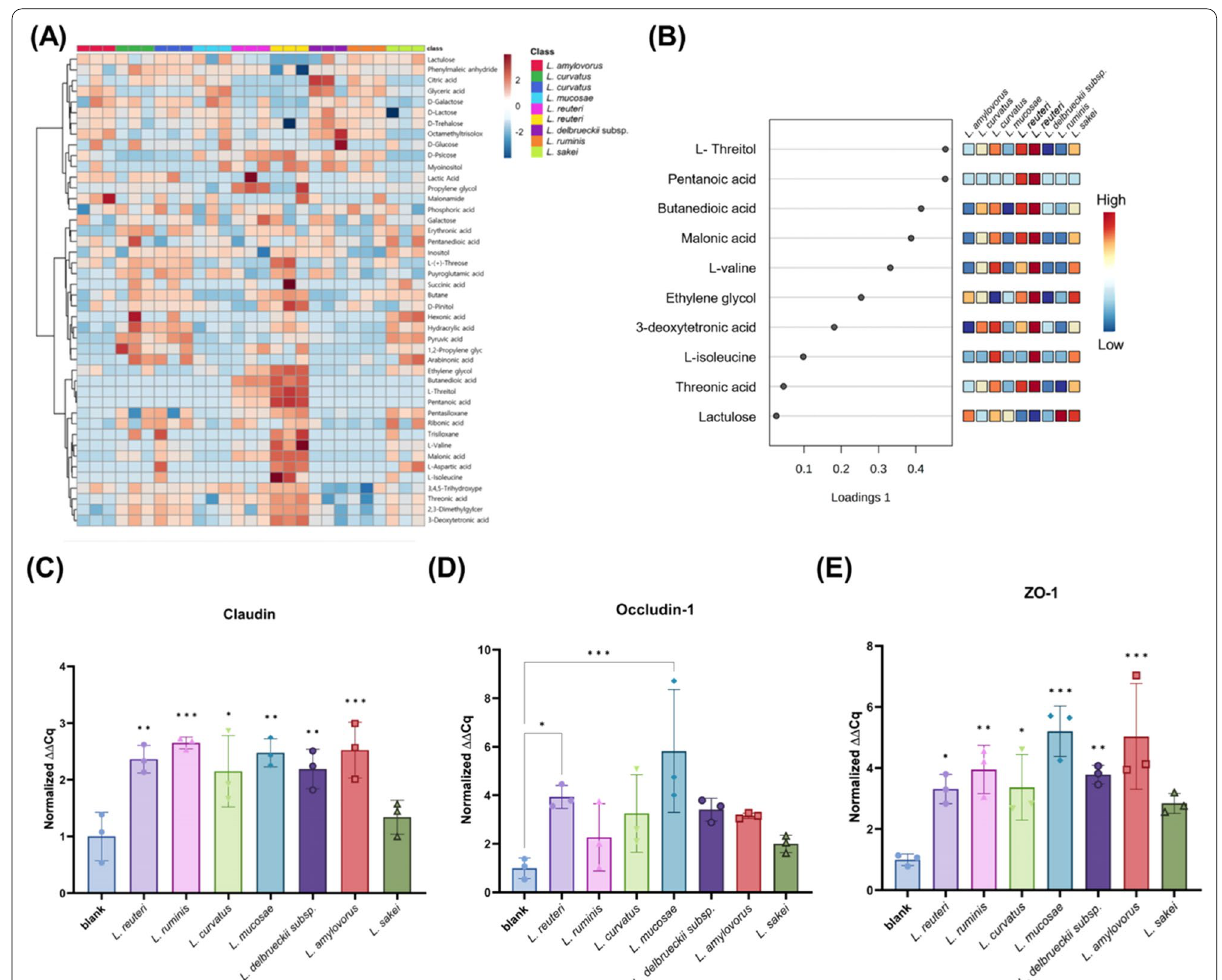
Fig. 7 Functional analysis of commensal Lactobacillus strains enriched by MSP supplementation. A Heatmap provides intuitive visualization of metabolites. Each colored cell on the map corresponds to a concentration. B The sparse PLS-DA (sPLS-DA) algorithm represent selected metabolites for given component. Metabolites are ranked by the absolute values of their loadings. C – E Tight junction gene expression of enriched commensal Lactobacillus strains by